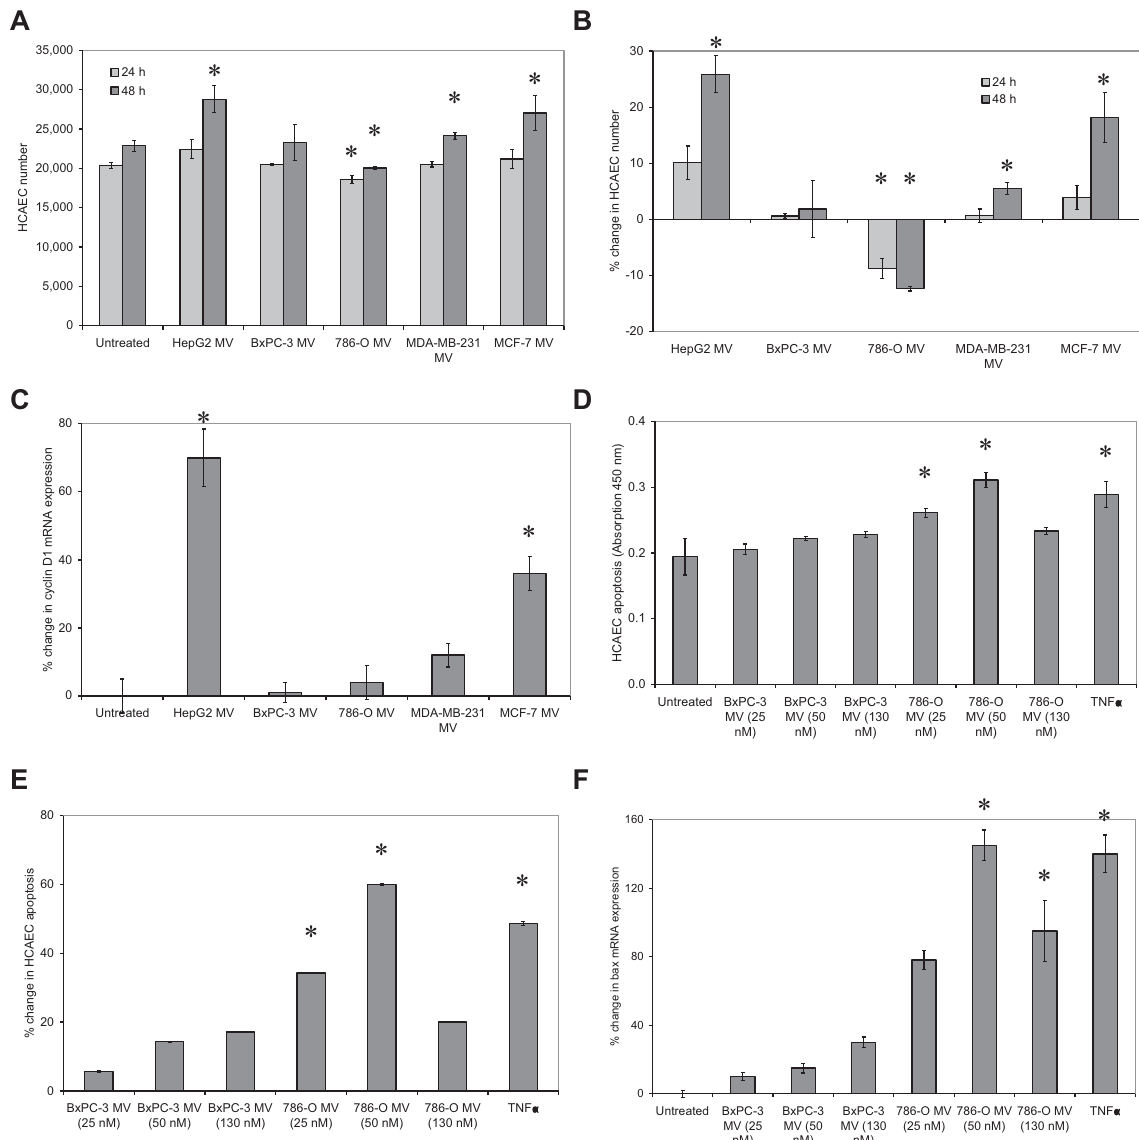
Fig. 2 Examination of the in fl uence of cell line-derived microvesicles on HCAEC cell numbers. Microvesicles were prepared from cell lines (HepG2, BxPC-3, 786-O, MDA-MB-231, and MCF-7), supplemented (50 nM) to HCAEC (2 (cid:1) 10 4 ) and incubated in for up to 48 hours. ( A ) Cell numbers were determined using the crystal violet staining assay and ( B ) the change in cell numbers was calculated as a percentage of the untreated cells ( n ¼ 5; (cid:4) ¼ p < 0.05 vs. the respective untreated sample at each time point). ( C ) Total RNA was extracted from samples of the treated HCAEC and the relative expression of cyclin D1 mRNA was analyzed by RT-PCR against β -actin as housekeeping ( n ¼ 3; (cid:4) ¼ p < 0.05 vs. the untreated sample). Cellular apoptosis was also measured (as absorption at 450 nm) in sets of HCAEC using the TiterTACS chromogenic TUNEL assay and ( D ) the change in level of apoptosis was calculated as a percentage of the untreated cells ( n ¼ 5; (cid:4) ¼ p < 0.05 vs. the untreated sample). ( E ) Total RNAwasextractedfrom samplesof thetreated HCAEC and the relative expressionof baxmRNAwas analyzedby RT-PCRagainst β -actin as housekeeping ( n ¼ 3; (cid:4) ¼ p < 0.05 vs. the untreated sample). HCAEC, human coronary artery endothelial cell; RT-PCR, reverse transcription polymerase chain